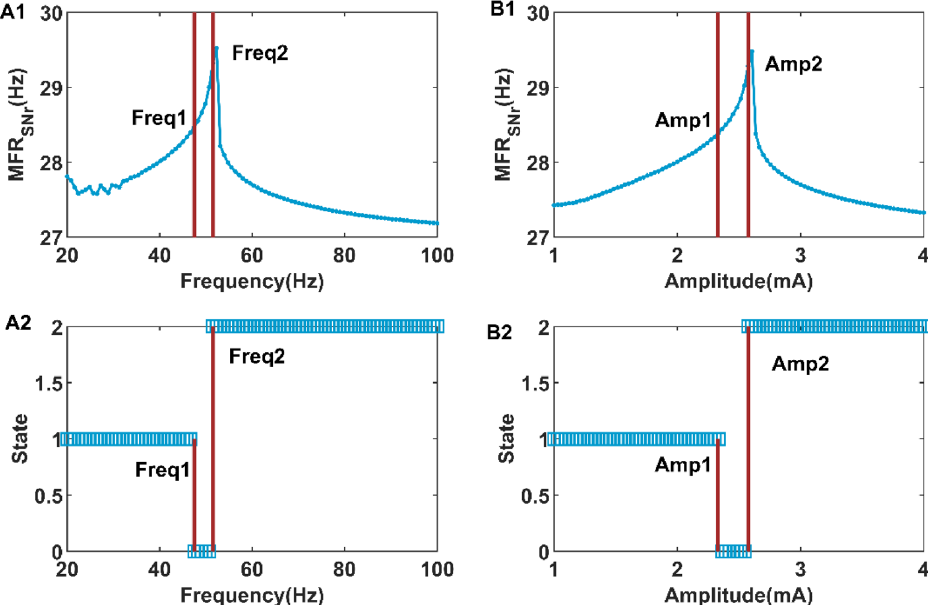
Figure 9. The mean firing rate ( A1 ) of SNr and the firing state ( A2 ) of cerebral cortex with the increase of DBS stimulation frequency. The mean firing rate ( B1 ) of SNr and the firing state ( B2 ) of cerebral cortex with the increase of DBS stimulation amplitude. The states 1, 0, and 2 represent SWDs oscillation state, simple oscillation state, and low firing state respectively.